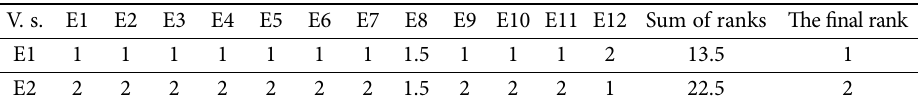
Table 6. Ranking factors in the group of technology features regarding the commercial potential of